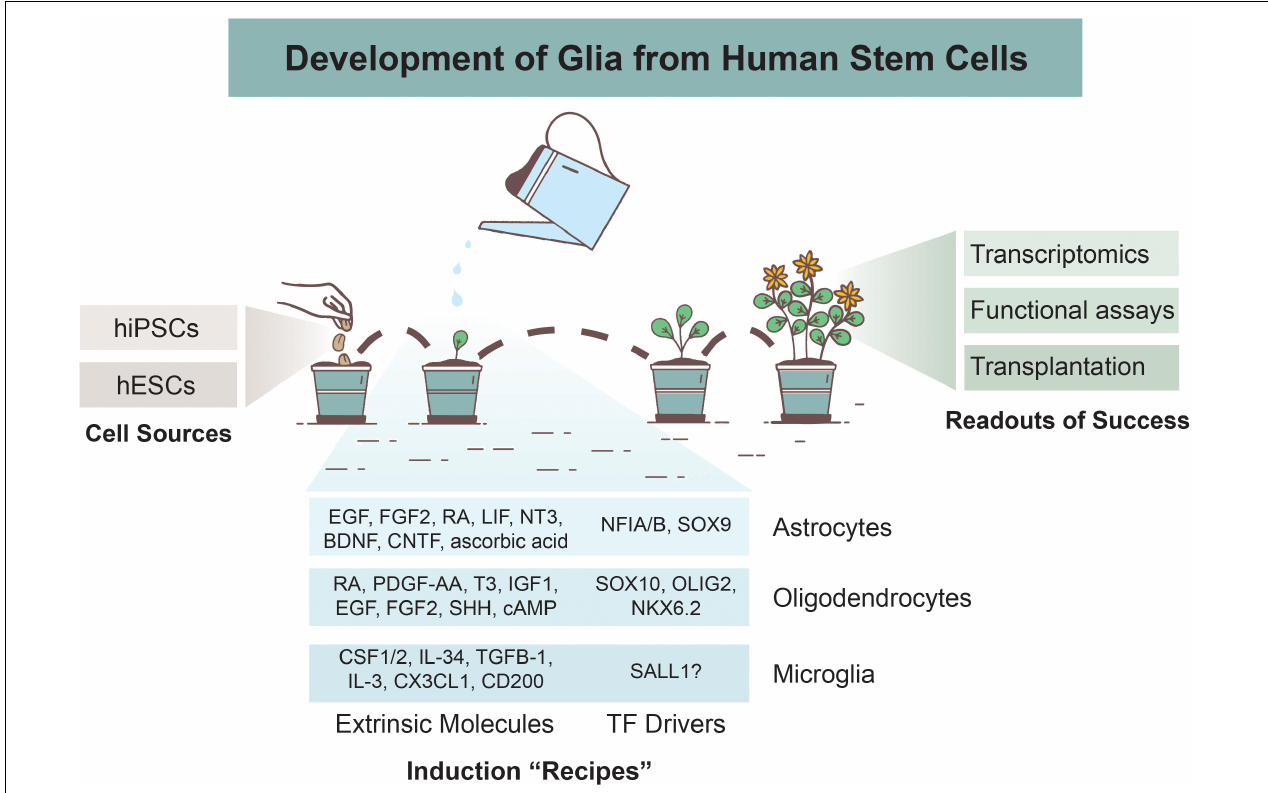
FIGURE 1 | Overview of Glial Development from Human Stem Cells. Astrocytes, oligodendrocytes, and microglia can be derived from human induced pluripotent stem cells (hiPSCs) or human embryonic stem cells (hESCs). Various differentiation protocols have been created to induce glial development via use of extrinsic patterning molecules and/or via induction of transcription factors (TFs). Numerous methods are used to determine successful differentiation and functionality of glial cells, including transcriptomics analyses, functional assays, and xenotransplantations.